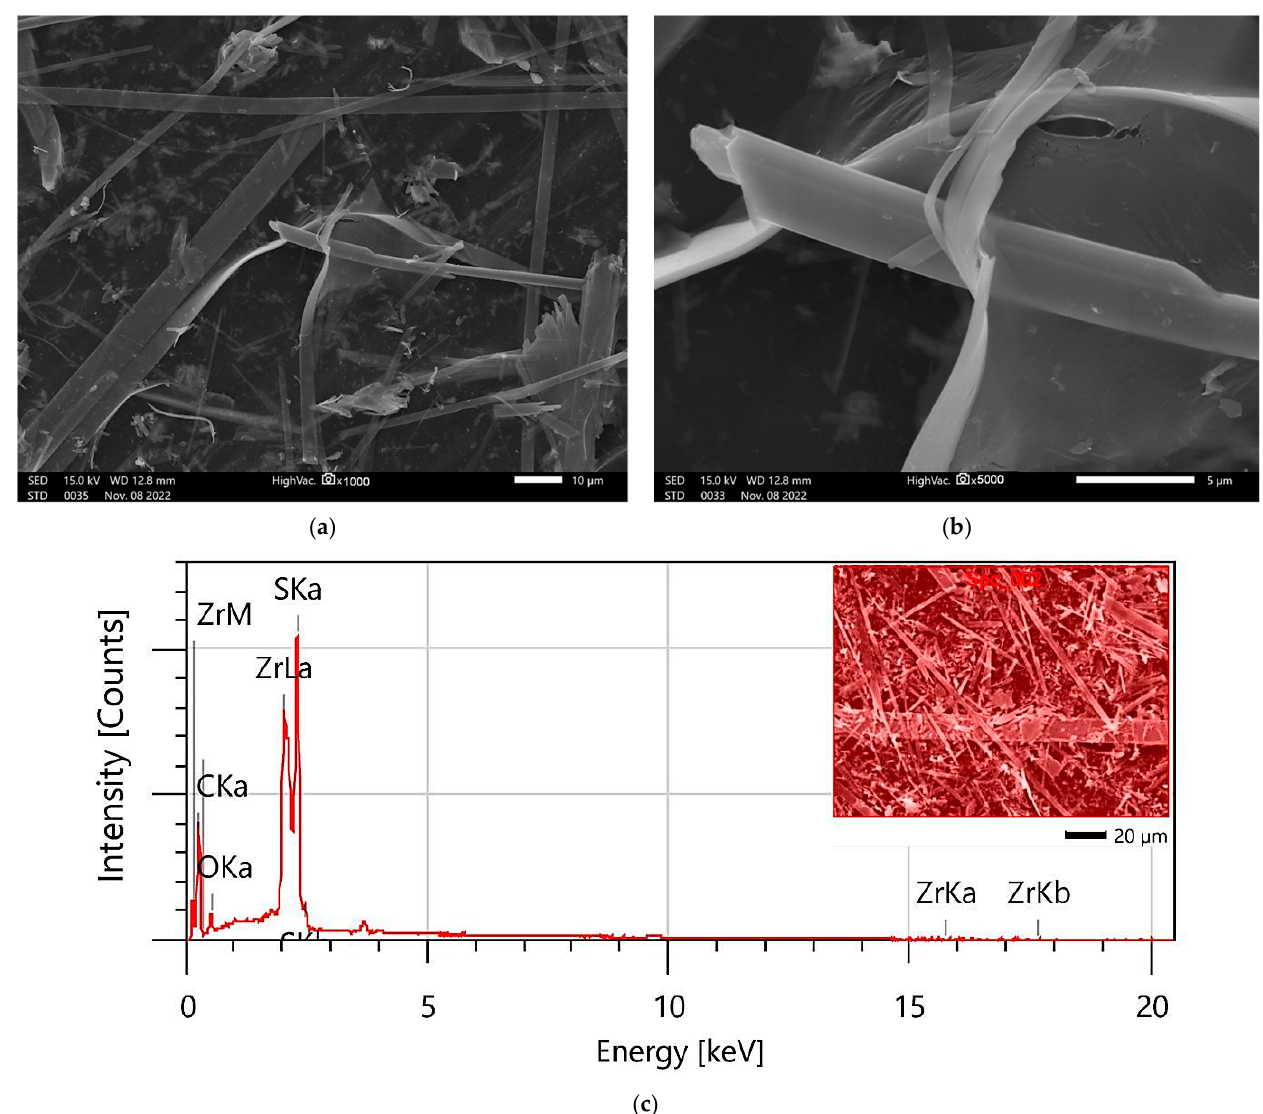
Figure 3. Analyses of ZrS 3 : ( a ) SEM image; ( b ) AFM image; ( c ) elemental composition (EDX). Figure 4a,b show microphotography of films consisting of the ZrS 3 and GO mix. The microphotographs show GO film covering ZrS 3 nanocrystals.